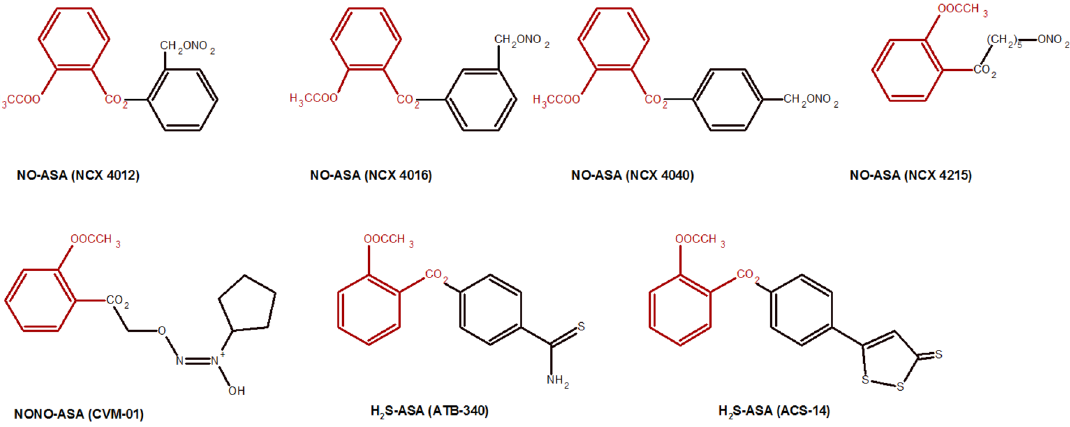
Figure 5. Chemical structures of NO-ASA and H 2 S-ASA derivatives. ASA moiety is marked in red.